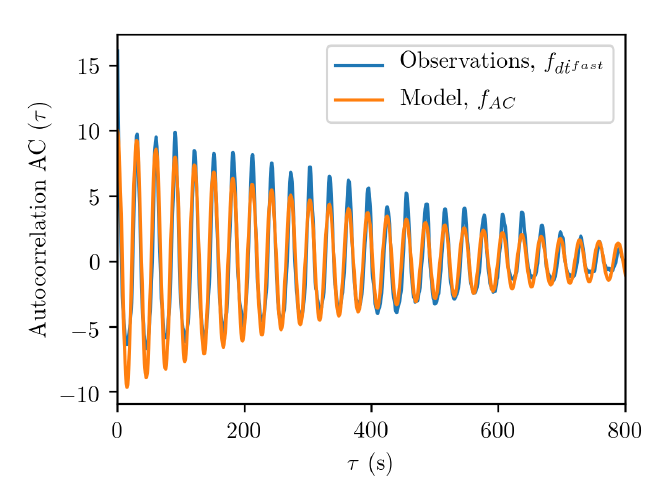
Figure 4. Autocorrelation function obtained from the clock drift d ˙ t fast data and the related model function f AC of Equation (26), for the u-blox receiver connected to the patch